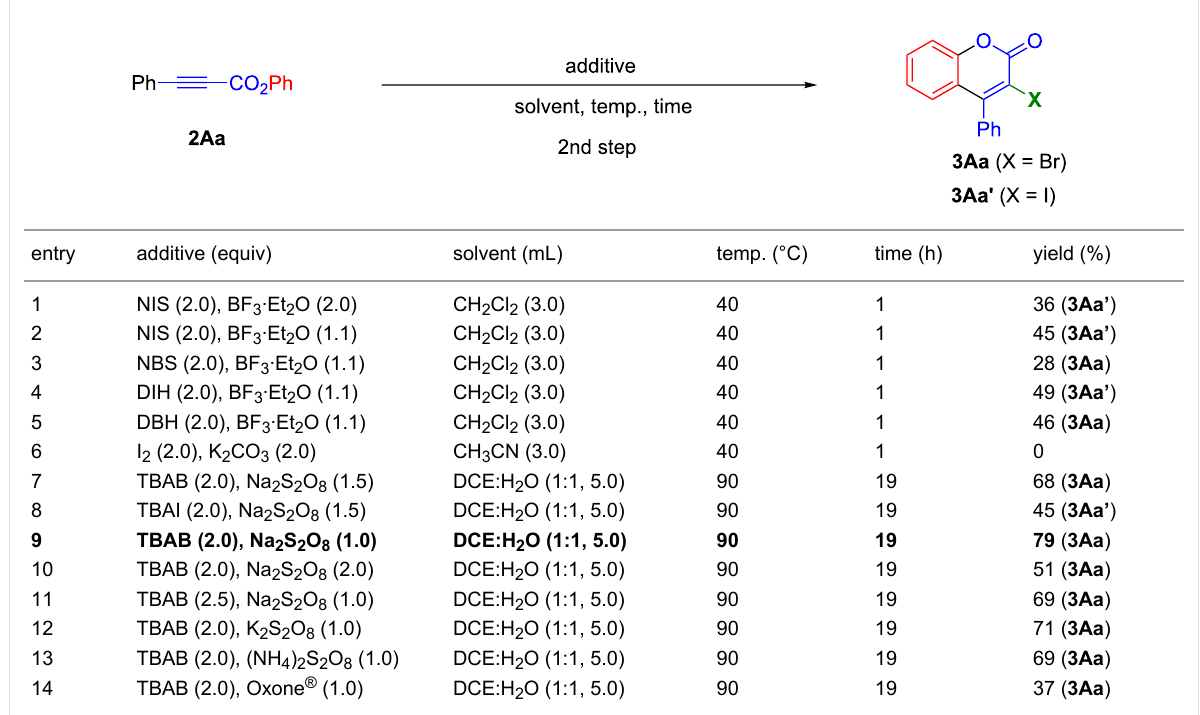
Table 2: Halocyclization of phenyl 3-phenyl-2-propynoate ( 2Aa ) to 3-halo-4-phenylcoumarins 3Aa and 3Aa’